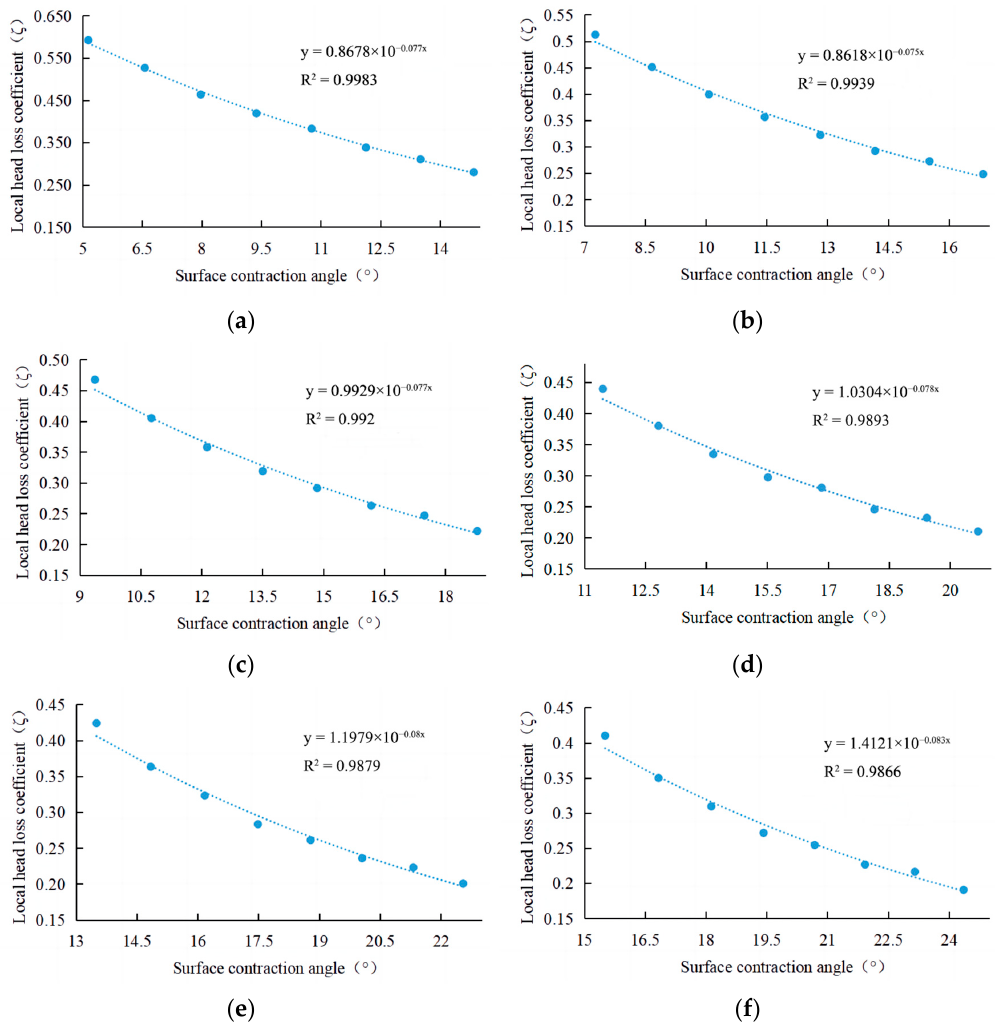
Figure 6. Each model working condition water surface contraction angle as a function of the local head loss coe ffi cient. ( a ) θ as a function of ζ at W up /W down 19/31; ( b ) θ as a function of ζ at W up /W down 22/31; ( c ) θ as a function of ζ at W up /W down 25/31; ( d ) θ as a function of ζ at W up /W down 28/31; ( e ) θ as a function of ζ at W up /W down 31/31; ( f ) θ as a function of ζ at W up /W down 34/31. As shown in Figure 7, the nonlinear regression analysis of W up /W down with exponen- tial function ζ = αe (cid:2962)(cid:3435)(cid:2907) (cid:3179)(cid:3174) /(cid:2907) (cid:3162)(cid:3173)(cid:3181)(cid:3172) (cid:3439) was performed for each model working condition.